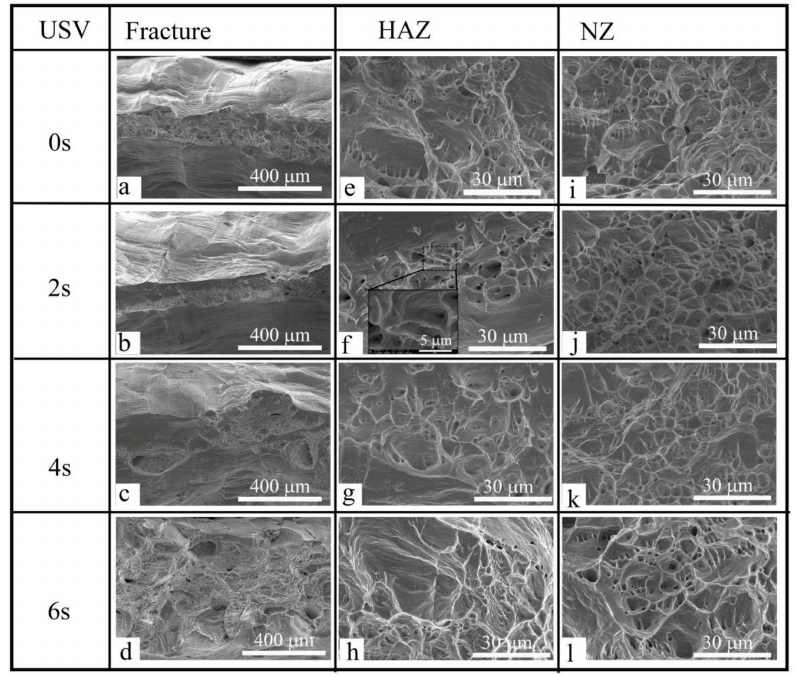
Figure 11. SEM images showing the fracture of copper GTA spot-welded joints with 0–6 s USV. ( a – d ) tensile-shear fracture surface; ( e – h ) HAZ fracture appearance; and ( i – l ) NZ fracture appearance.